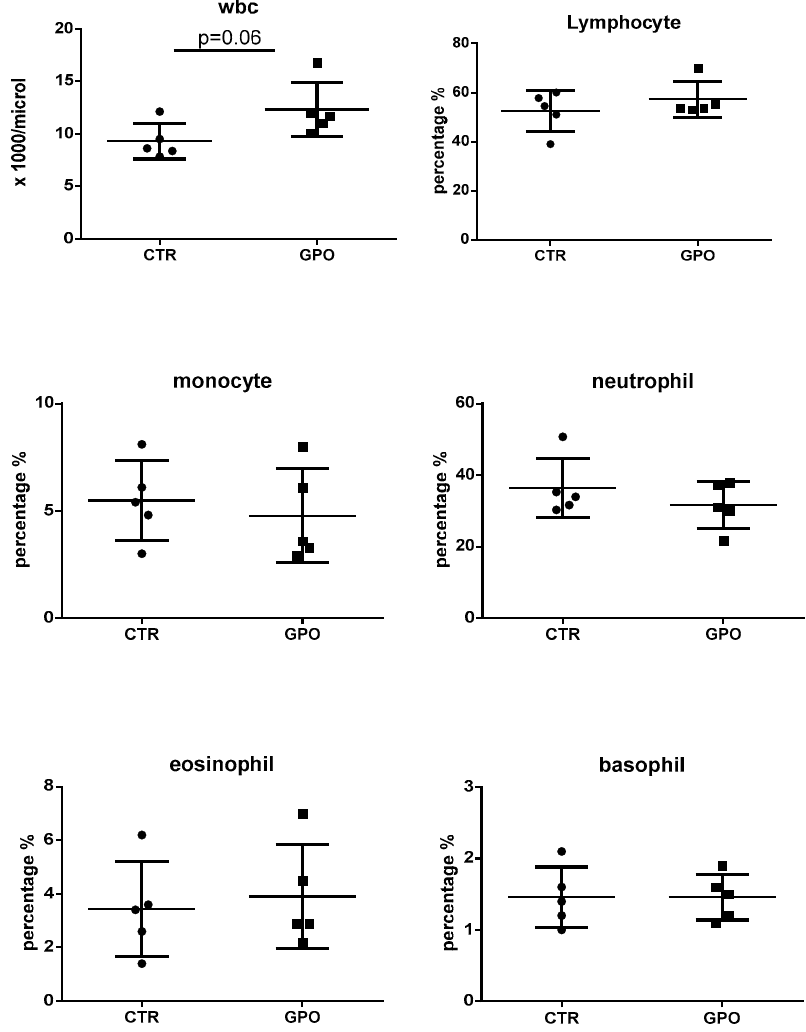
Figure 1. Effect of grape pomace (GPO)-supplemented diet on blood cell counts. Each point represents a single subject, and data are expressed as percentage. Any possible differences were analyzed by using the Student’s t -test. CTR: a control group.